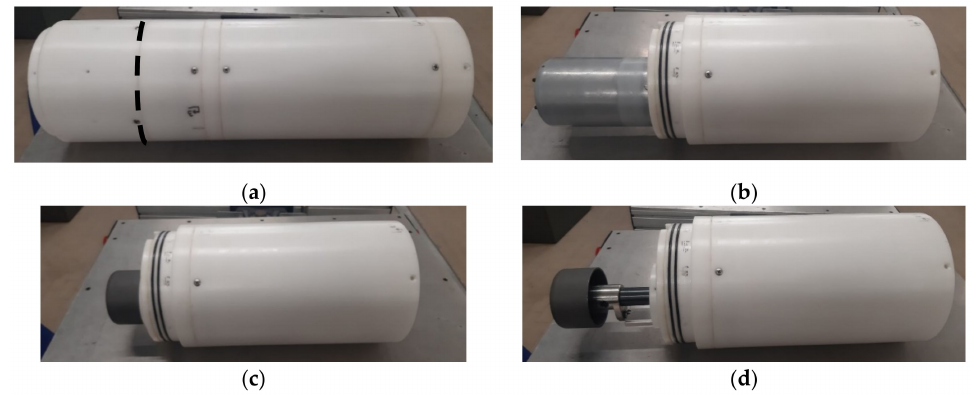
Figure 13. Developed prototype: ( a ) complete; ( b ) without front cap; ( c ) without front cap and cylinder body, retracted; ( d ) without front cap and cylinder body, extended.